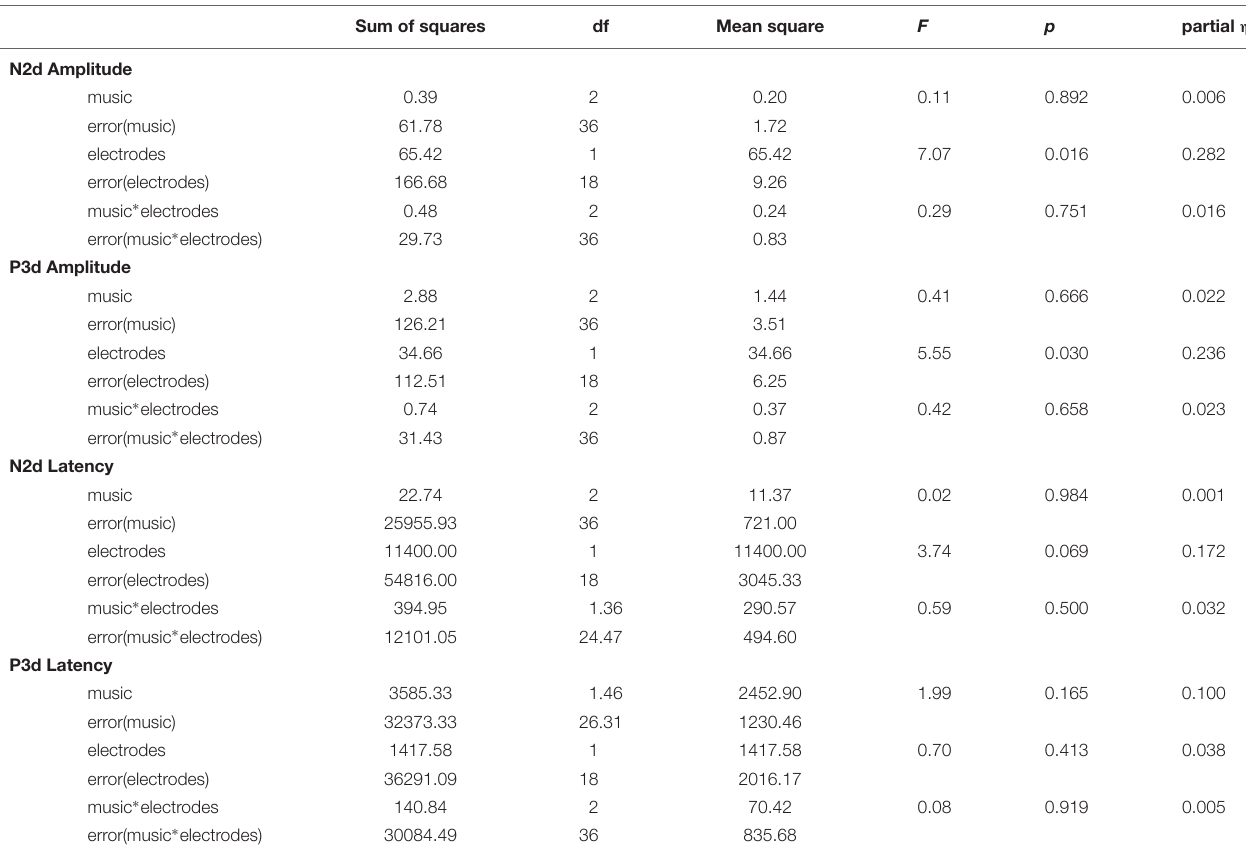
TABLE 2 | Results of the two-way repeated measures ANOVAs for the N2d and P3d amplitudes and latencies. Sum of squares df Mean square F p partial η 2